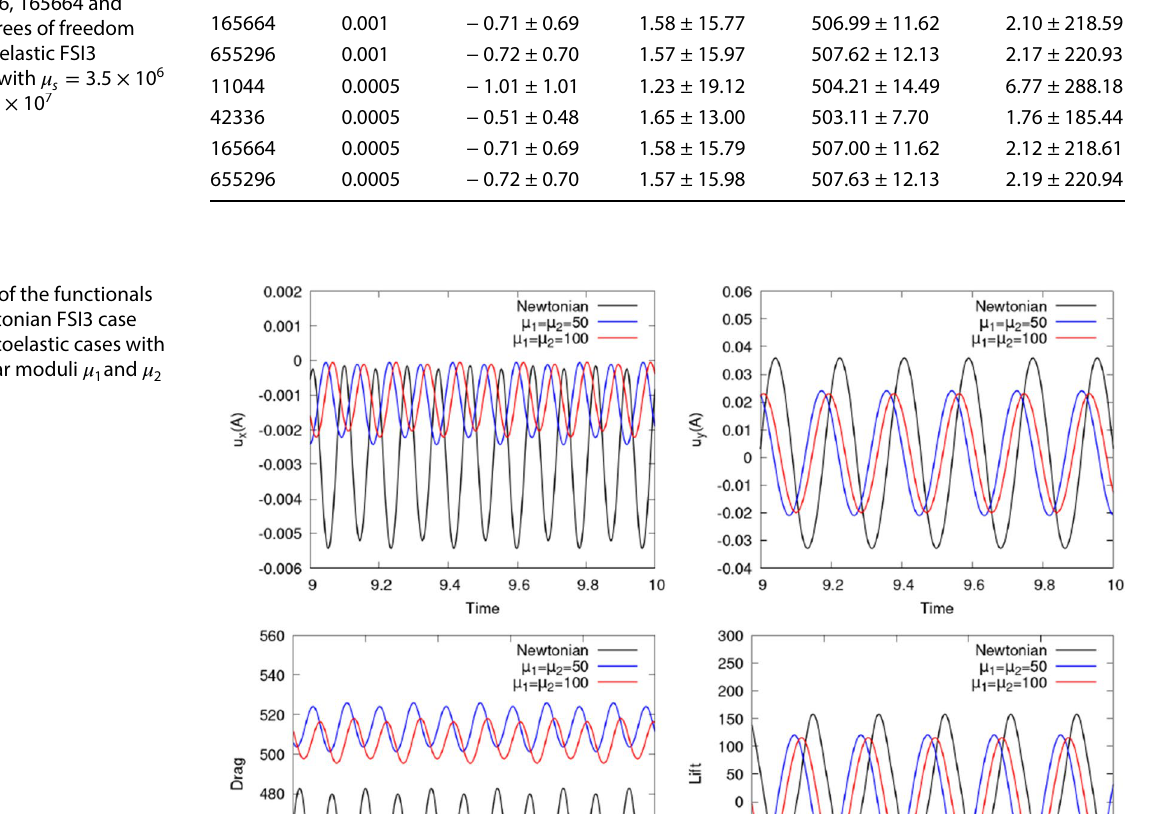
Table 3 Results for the quantities of interest for the mean and the amplitude on four different mesh levels with 11044, 42336, 165664 and 655296 degrees of freedom for the viscoelastic FSI3 benchmark with 𝜇 s = 3.5 × 10 6 and 𝜆 s = 1.4 × 10 7